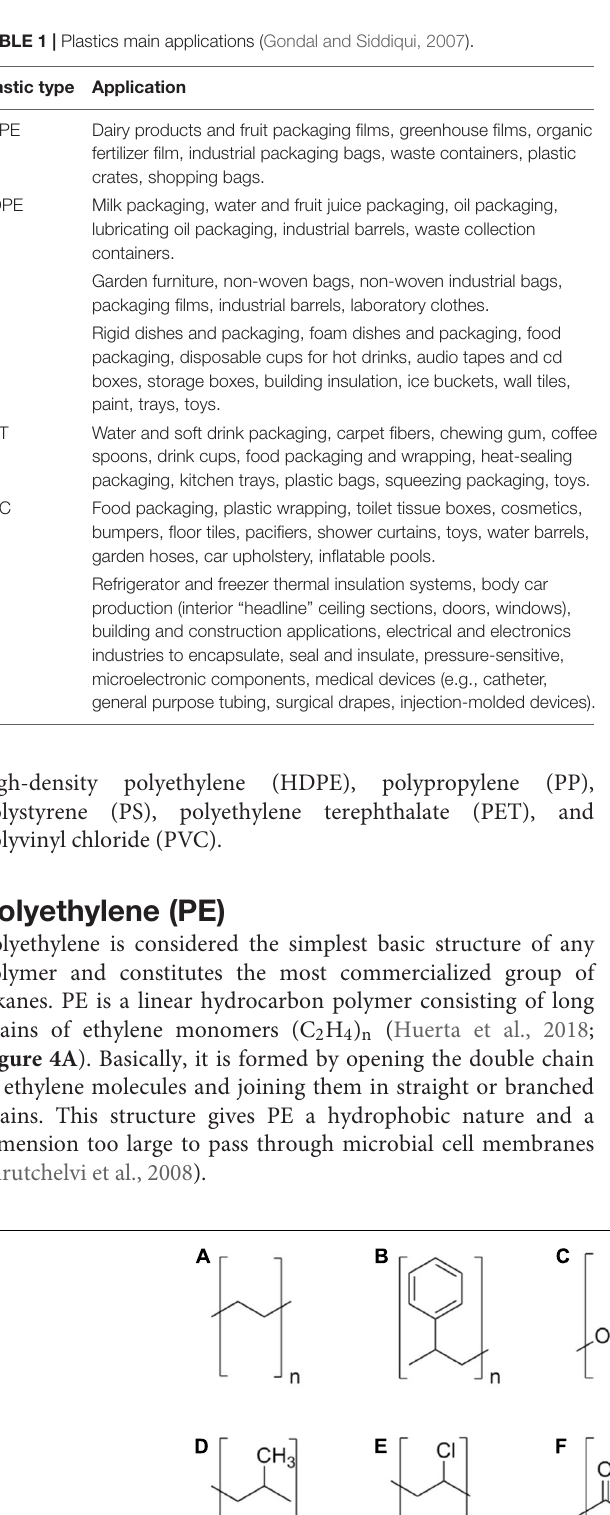
Frontiers in Marine Science |